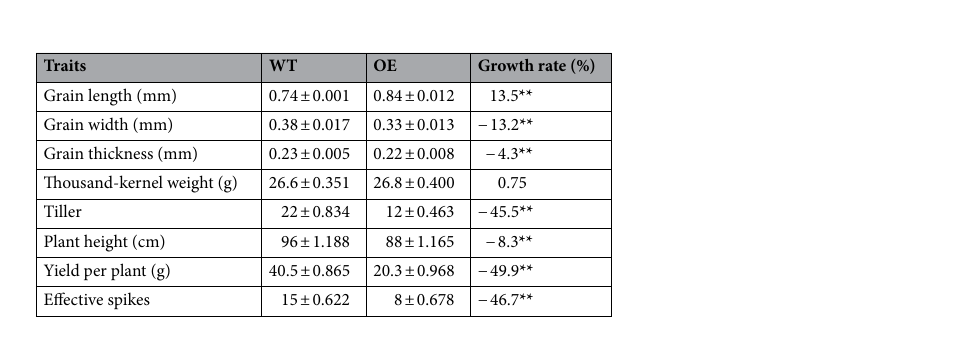
Table 1. Agronomic traits of WT and OsSCL30-OE of rice. The data in the table are mean ± 10 standard deviations; Asterisks indicate significant differences between WT and OsSCL30-OE ( * P < 0.05, ** P < 0.01).